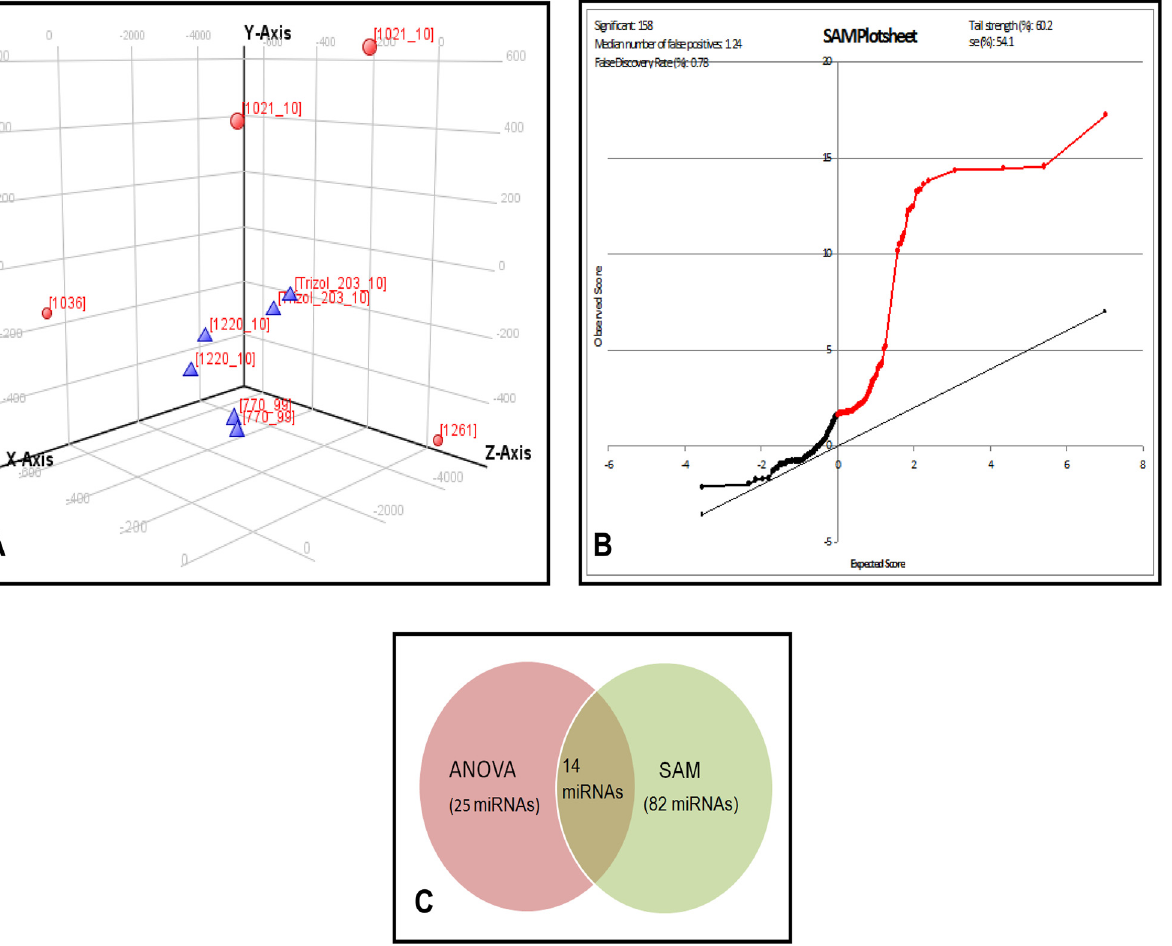
Fig 1. Unsupervised and supervised analysis of miRNA expression in UM. A: Graphical representation of the unsupervised analysis: principal component analysis (PCA) for the UM tumor tissues: M3 (n = 3), and D3 (n = 3) showing the clustering of samples correspondingly in to two distinct groups (M3 and D3). Blue colored triangle denotes M3 UM tumors while red colored spheres denotes D3 UM tumors. B: Supervised analysis: The significance analysis of microarray (SAM) plot reveals the de regulated miRNAs between the monosomy and disomy formalin fixed UM primary tumors. The false discovery rate (FDR) has set at Q = 0.78%. The list of miRNAs with Q = 0.0 has been considered for the validation by qRT-PCR. C: Venn diagram on intersection of miRNAs obtained from ANOVA and SAM. miR-134 , miR-1238 , miR-149 * are the common select miRNAs observed from this study.